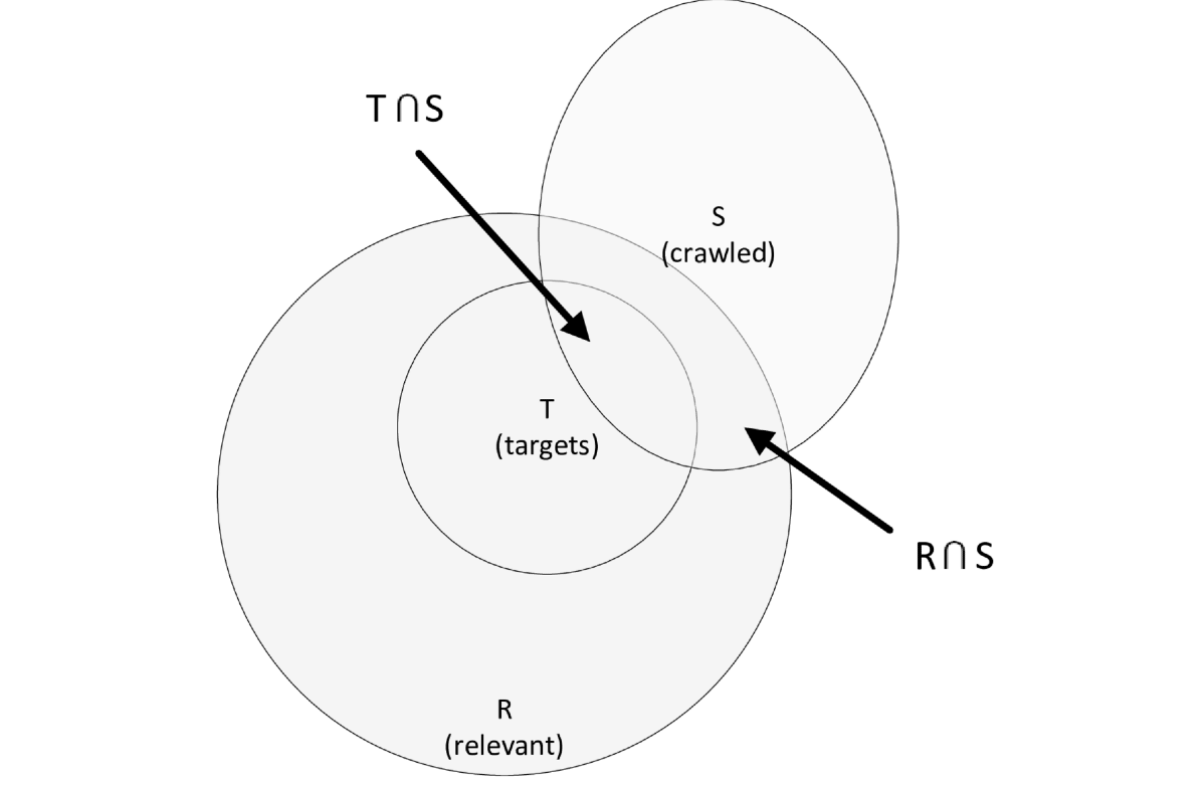
Figure 4. Recall estimate